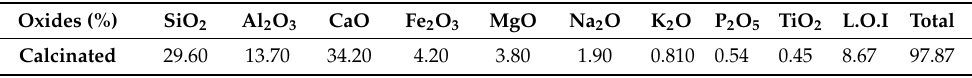
Table 1. Percentages of mineral oxides presented in calcinated bentonite.